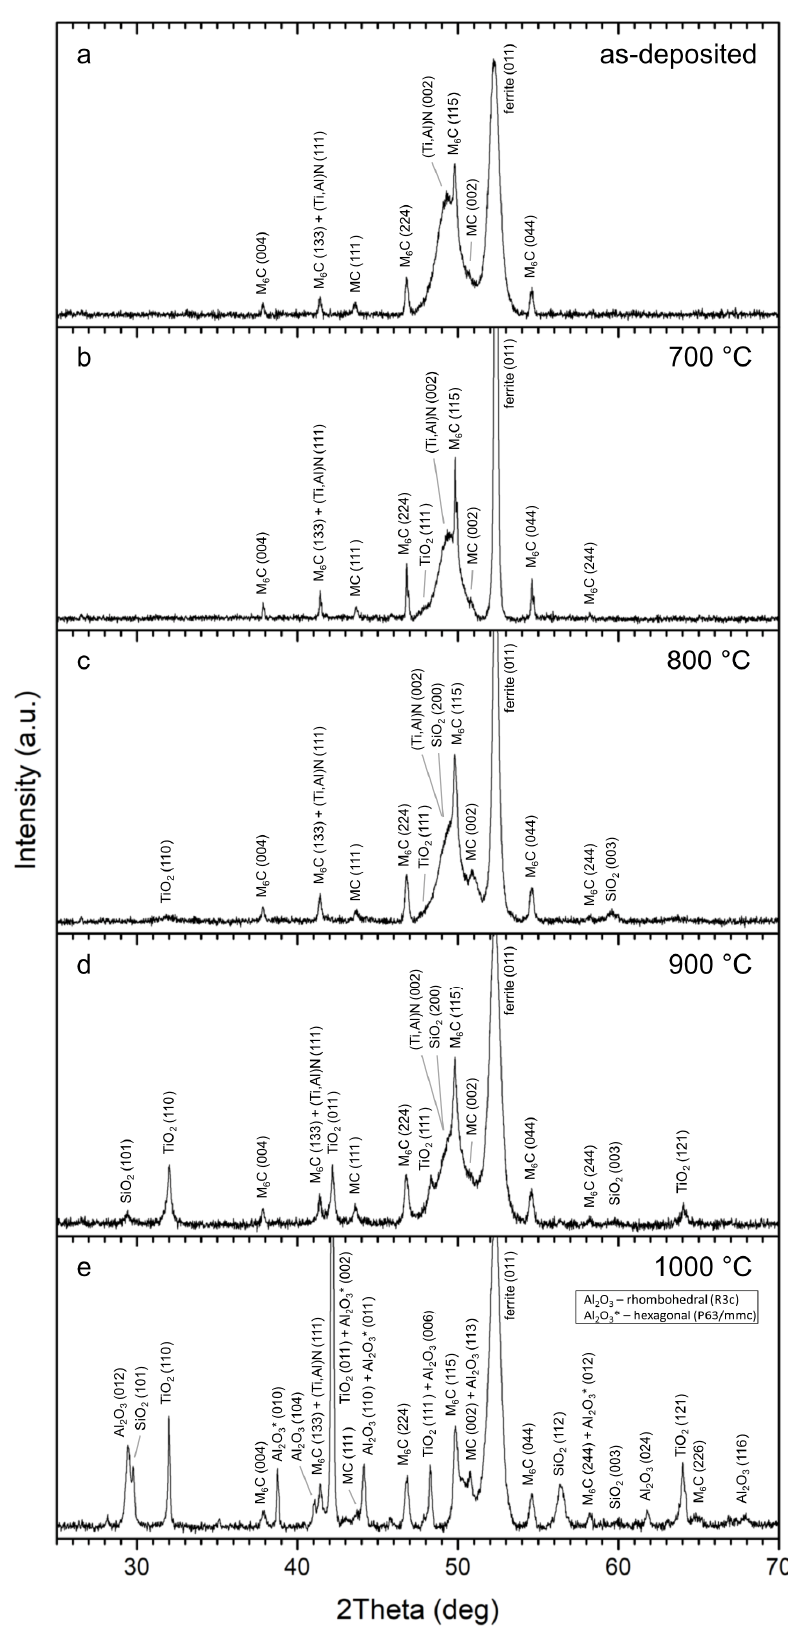
Figure 7. XRD patterns of the investigated samples: as-deposited state ( a ) and annealed at 700 °C ( b ), 800 °C ( c ), 900 °C ( d ) and 1000 °C ( e ).